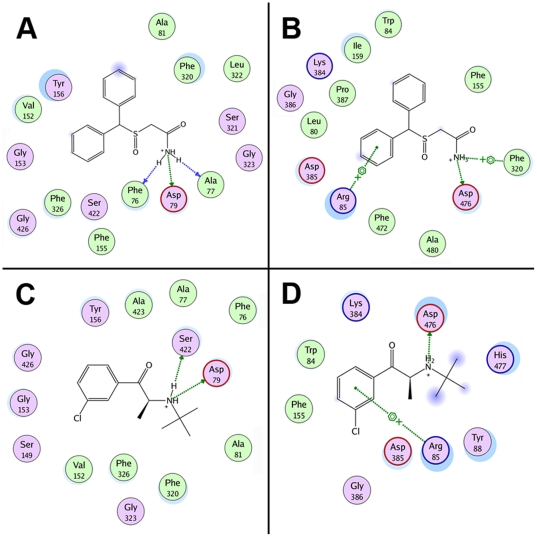
Molecular interaction diagrams of docked atypical inhibitors.For each panel, the interaction map depicts DAT residues located within 4.5 Å of the bound inhibitor molecule (hydrophobic residues are colored green and polar residues are purple). The most significant (non van der Waals) DAT/ligand interactions are indicated with dotted lines and a symbol depicting the chemistry of the interaction formed: side-chain hydrogen bond (green), main-chain hydrogen bond (blue), cation-π bond (+) or aromatic π-stacking (
). (A, B) Residue interaction maps for modafinil bound at the S1 (A) and S2 sites (B). (C, D) Interaction maps for bupropion bound at the S1 (C) and S2 sites (D), respectively. For both of the atypical inhibitors, binding at the S1 site (panels A and C) gives rise to few strong interactions with the DAT—only their protonated nitrogen atoms form hydrogen bonds—suggesting that recognition of these relatively modest inhibitors (K
i>100 nM) is influenced more by molecular shape and steric bulk than by specific polar interactions.